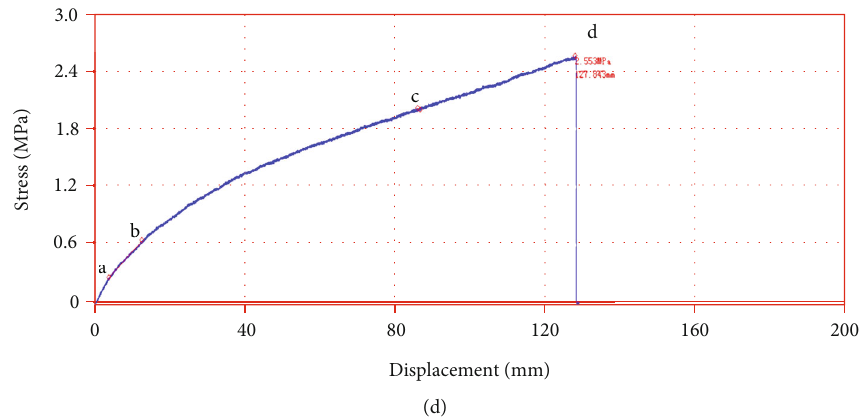
Figure 10: Tensile stress-displacement curves under the condition of (a) bionic structure, 0.2mm crimping amount; (b) traditional structure, 0.2mm crimping amount; (c) bionic structure, 1.0mm crimping amount; (d) traditional structure, 1.0mm crimping